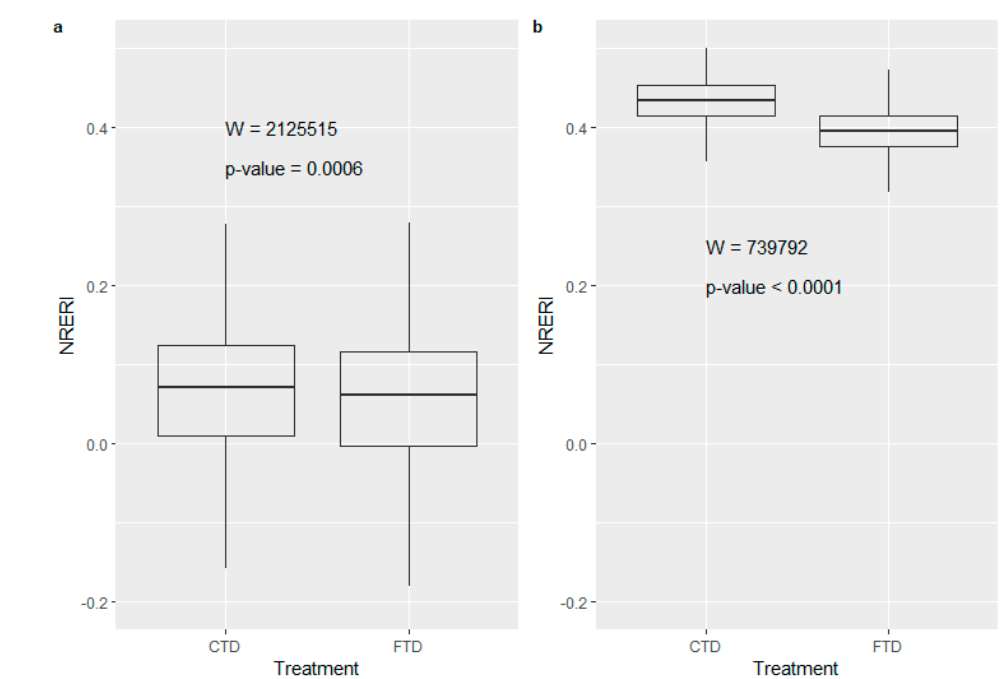
Figure 6. NRERI box plots with Mann-Whitney U test (W, p-value) at CTD and FTD sites with Dystric Cambisol in the Za Frajmankou field from UAV imagery on (a) 2 June 2021 and (b) 30 June 2021.